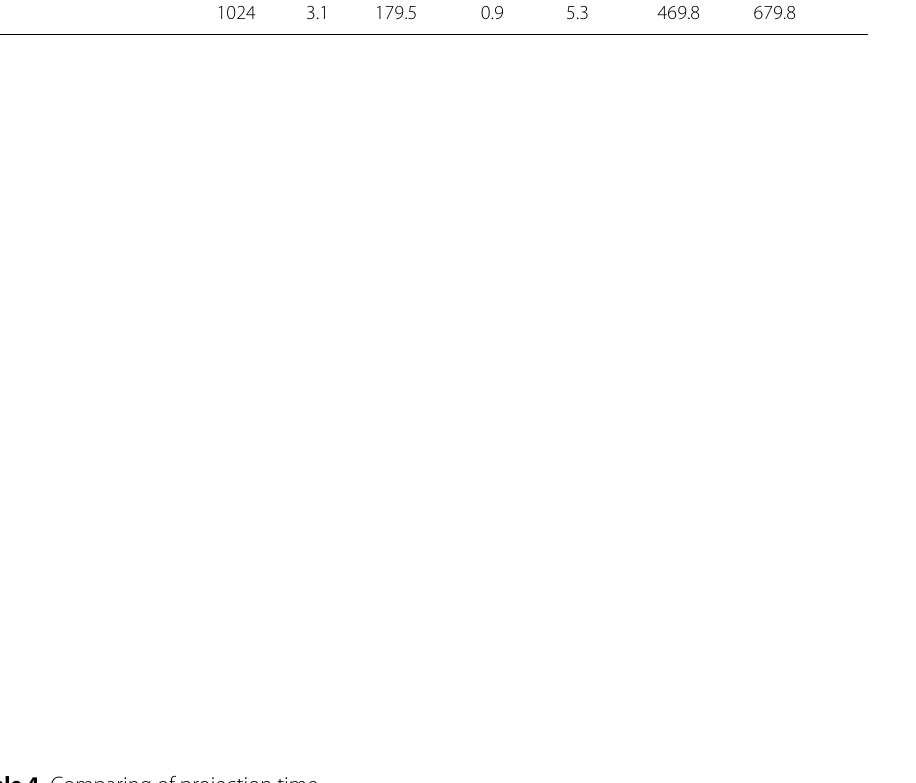
Table 4 Comparing of projection time